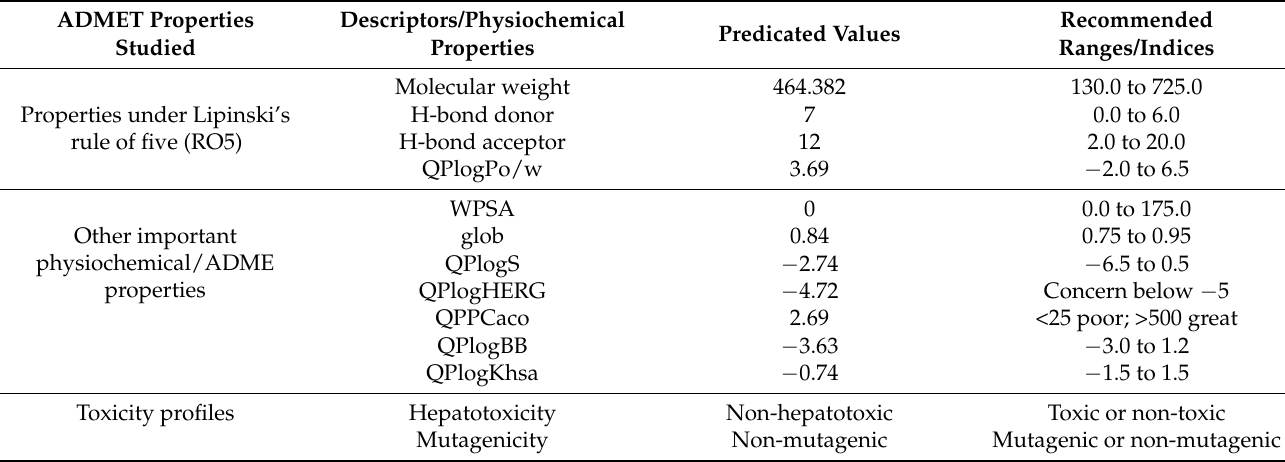
Table 3. Computationally predicted absorption distribution metabolism excretion, and toxicity (ADMET) and other drug-likeness profiles of